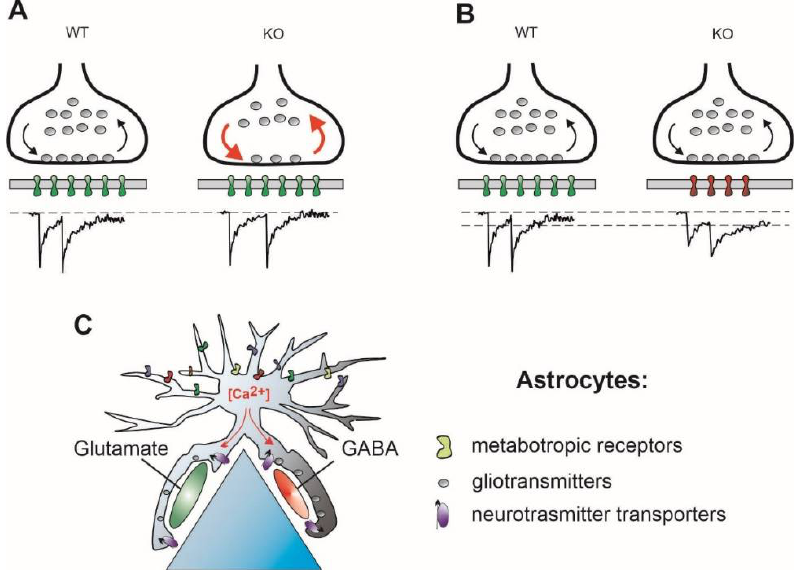
Figure 2. Possible mechanisms operating to correct the E/I imbalance but leading to a distorted timing of synaptic transmission. ( A ) Presynaptically, reduced RRP size may be counterbalanced by faster vesicle recycling rate, red arrows, supporting proper synaptic function during periods of activity (Mecp2-KO and FMR1-KO). Note a temporal jitter of postsynaptic responses at KO synapses. ( B ) Postsynaptically, reduced number of postsynaptic receptors, a smaller quantal size, is compensated for by involvement of slower postsynaptic receptors, stabilizing, in turn, the quantal charge (FMR1-, Nlg4-, and DTNBP1-KO). ( C ) Astrocytic ionic signaling induced by neuronal activity leads to spatially heterogeneous release of gliotransmitters and/or changes in neurotransmitter uptake rate (Nlg4-KO).